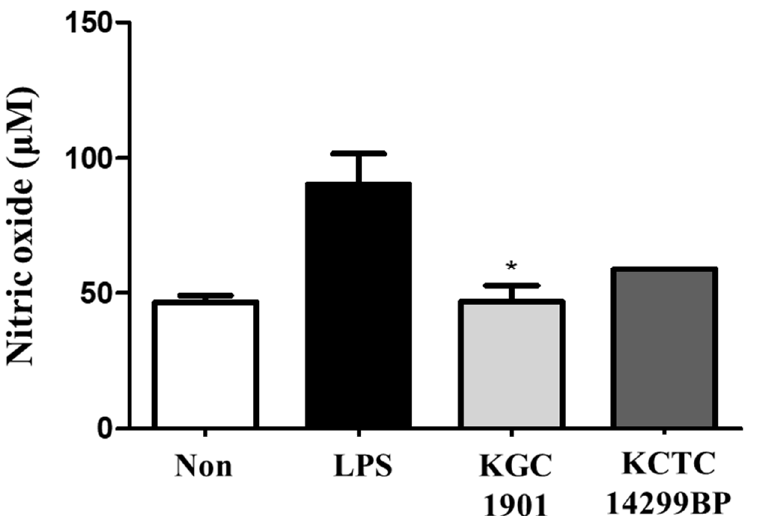
Figure 7. Nitric oxide production of L. reuteri KGC1901 in lipopolysaccharide-induced RAW 264.7 cells. Significant correlation between LPS and L. reuteri KGC1901 treatment is shown by asterisk (* p < 0.05).